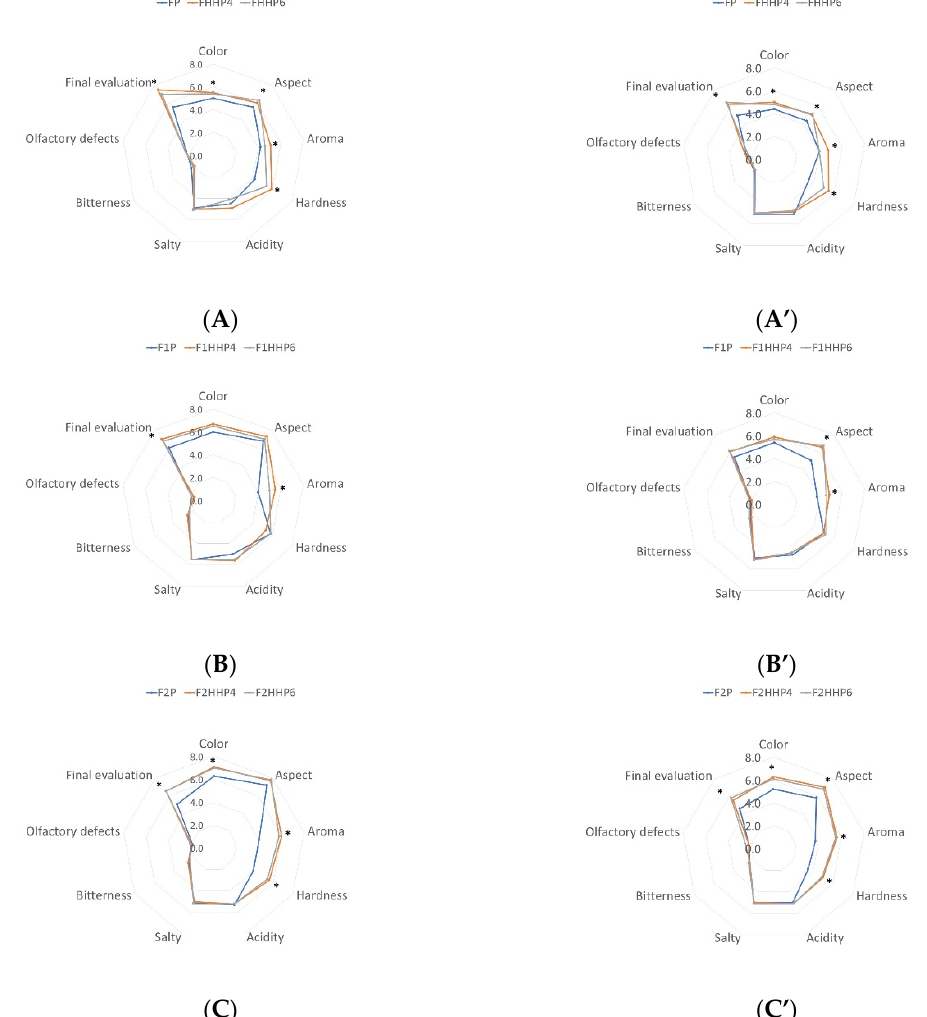
Figure 3. Spider plots of the sensory descriptors of fermented olives after the treatments ( A – C ) and after 117 days of storage ( A’ – C’ ). Control olives (F), without inoculation or OLE addition: FP, pasteurized; FHHP4 and FHHP6, treated with HHP. Olives with OLE and non-inoculated (F1): F1P, pasteurized; F1HHP4 and F1HHP6, treated with HHP. Olives inoculated with S. cerevisiae strain and added with OLE (F2): F2P, pasteurized; F2HHP4 and F2HHP6, treated with HHP. *: statistically significant differences (Tukey’s Test, p < 0.05) among conservation treatments at the same storage time.